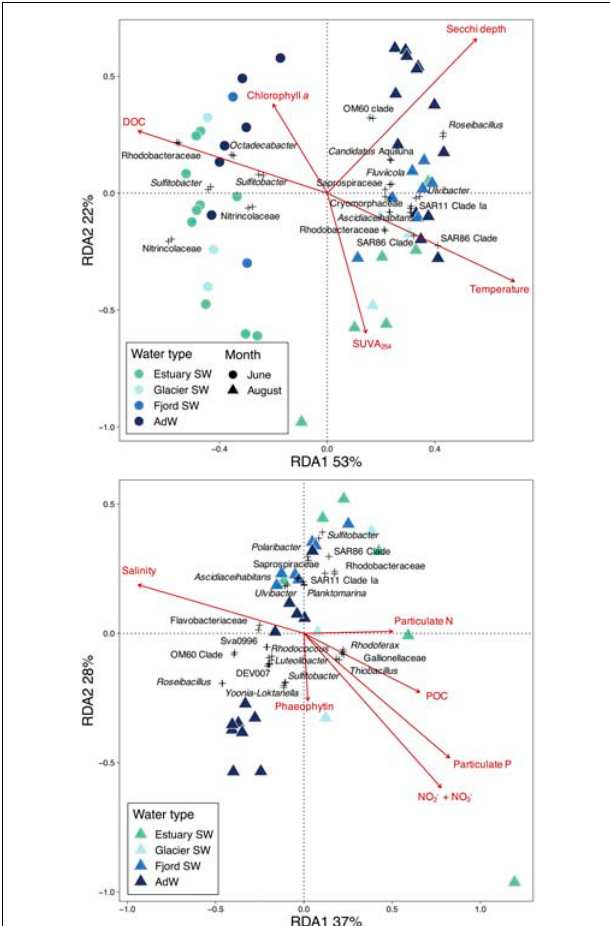
FIGURE 6 | Redundancy analysis (RDA) with environmental drivers of community structure (A) highlighting seasonal gradients in the fjord water column, and (B) highlighting the spatial gradient in the fjord water column in August. Significant constraining variables are indicated in red. RDAs were run on OTUs, and only OTUs with an RDA score > 0.07 are represented and are scaled by 3. The name of the closest related genus or family (highest specified taxonomic resolution) is given for these OTUs. Percentages indicate the amount of variance explained by each